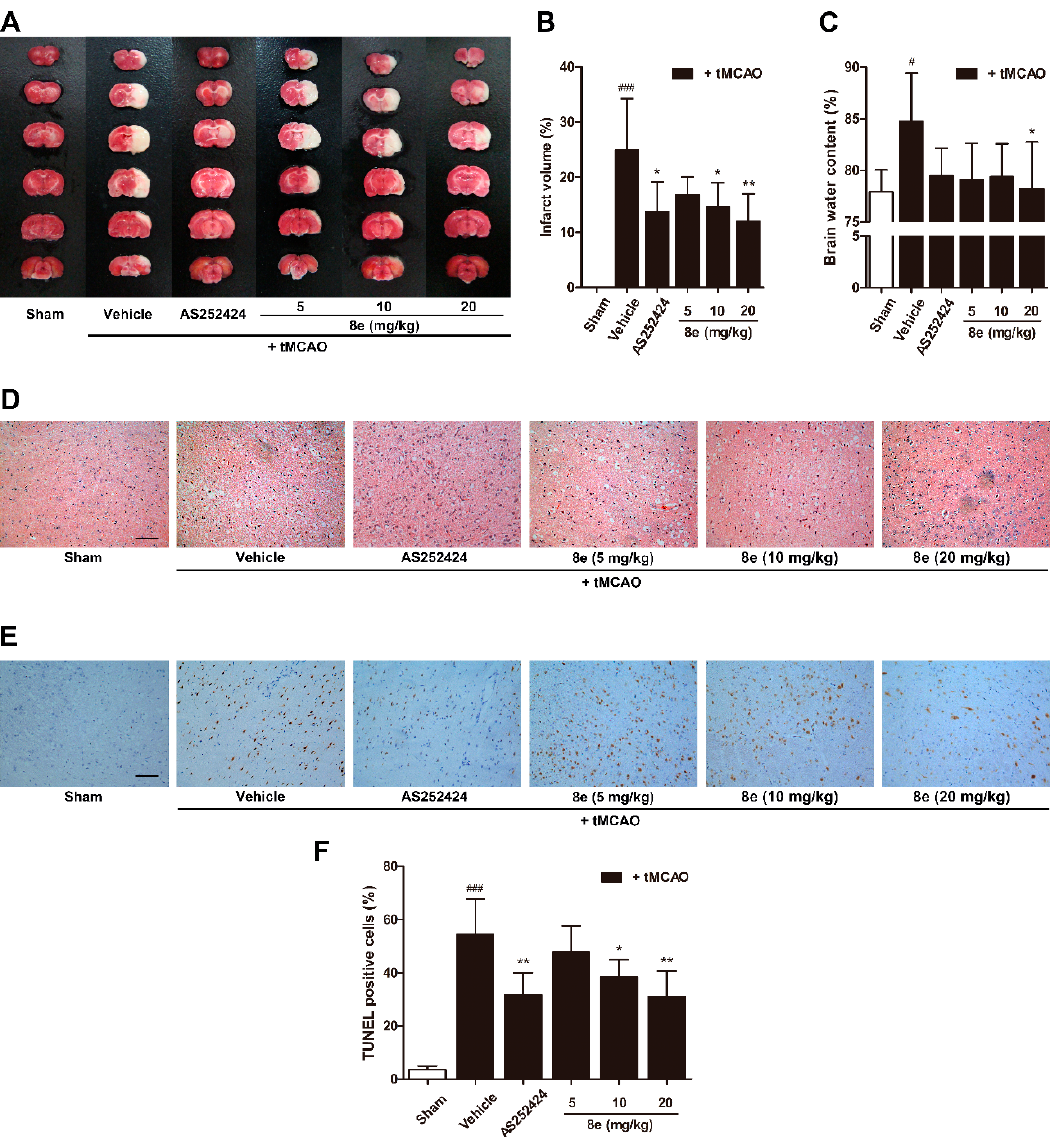
Figure 3. 8e protected against cerebral I/R injury, histological damage and neural apoptosis at 72 h after tMCAO in rats. ( A ) Representative images of TTC staining on rat brain sections; ( B ) quantitative analysis of infarct volumes in TTC staining ( n = 6); ( C ) brain water contents in ipsilateral hemispheres ( n = 6); ( D ) representative images of H&E staining; ( E ) TUNEL staining at 200 × magnification. Scale bar = 100 μ m; ( F ) quantitative analysis of the percentage ratios of TUNEL positive cells ( n = 3). Data are presented as mean ± SD. # p < 0.05, ### p < 0.001 vs. sham group. * p < 0.05, ** p < 0.01 vs. tMCAO + vehicle group.